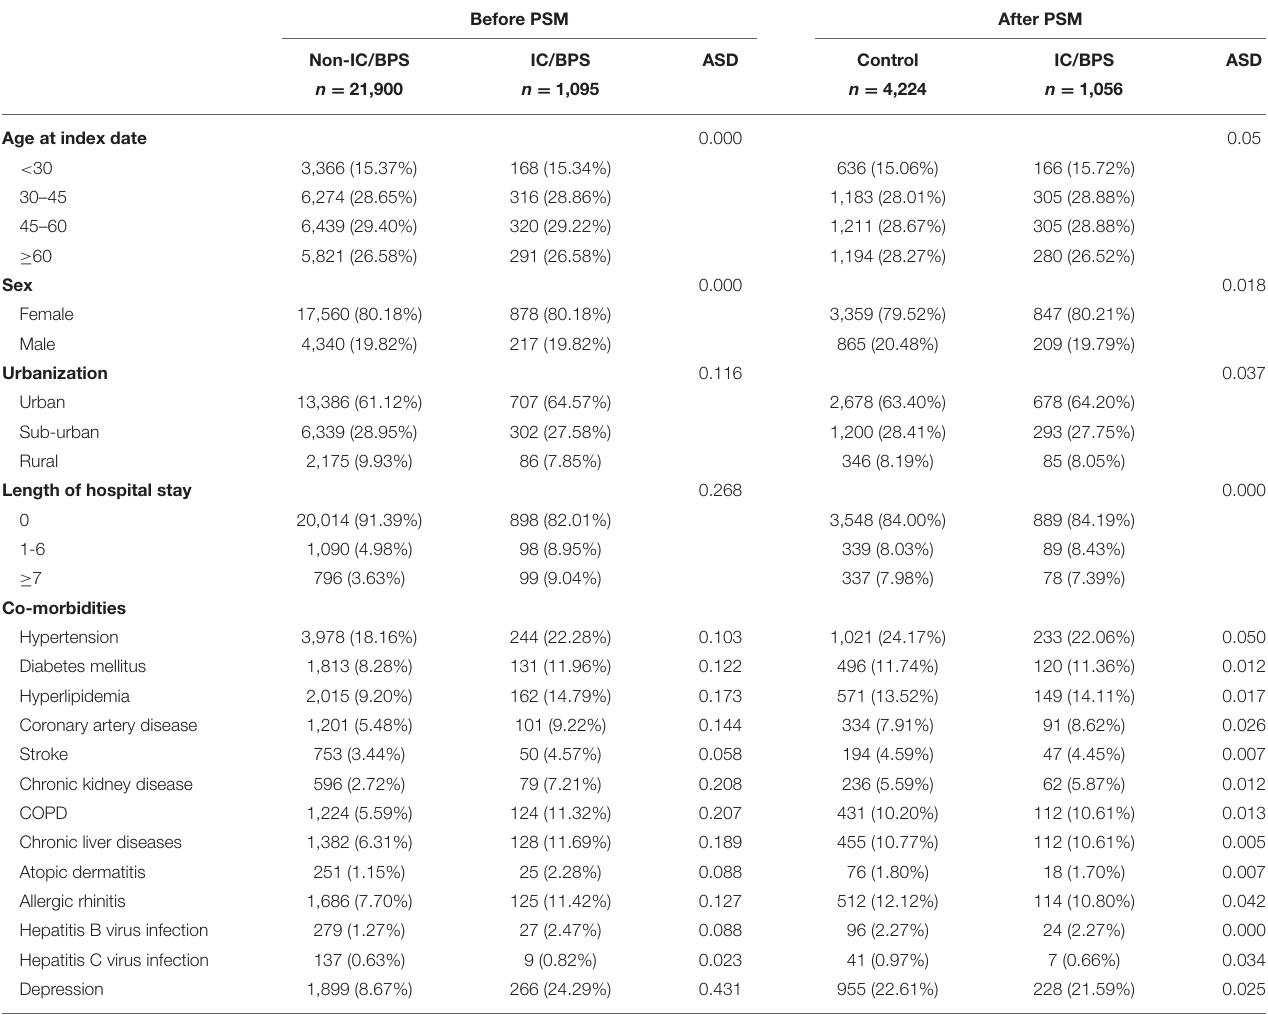
TABLE 1 | Demographic variables and comorbidities of patients with IC/BPS and paired non-IC/BPS individuals. Before